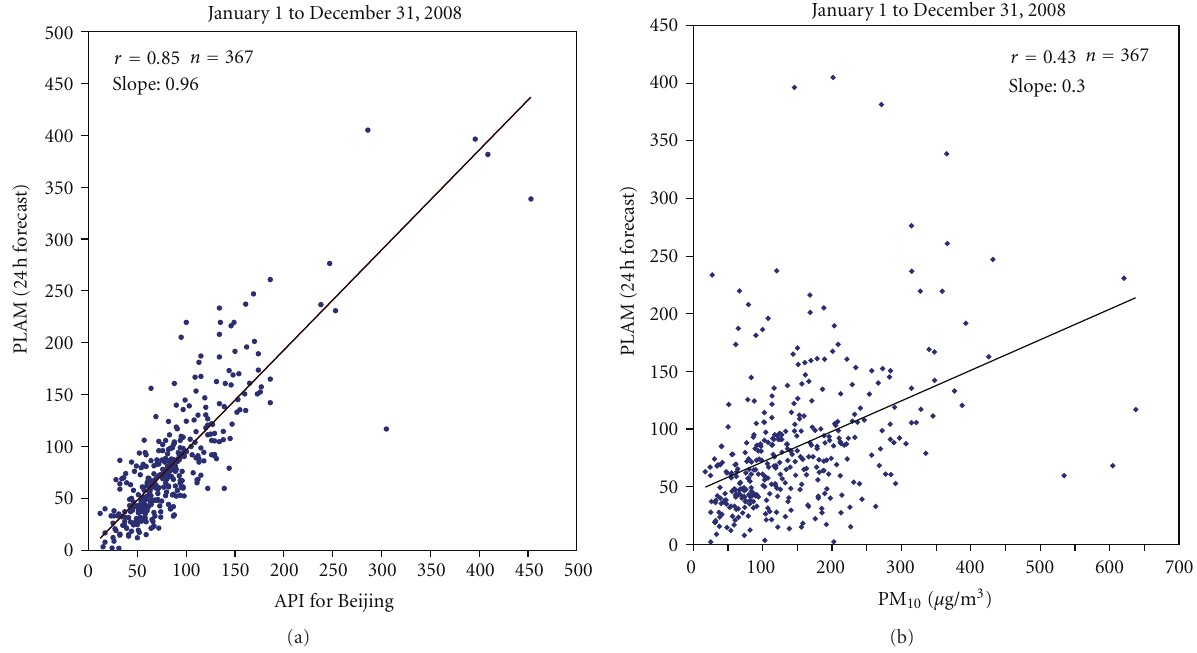
Figure 5: Correlations of 24 h PLAM forecast results with API of Beijing (a) and actual PM 10 in Beijing (b) for the period from 1 January to 31 December 2008.